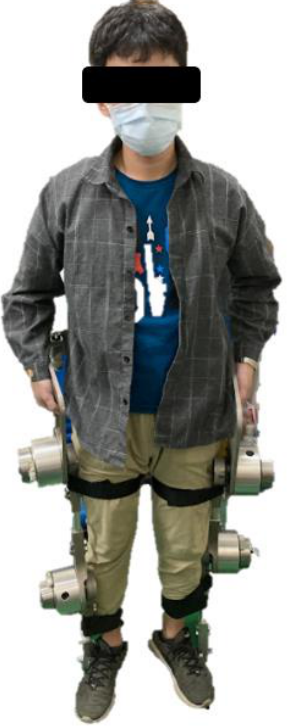
Figure 14. Wearer with the LLRE-II.